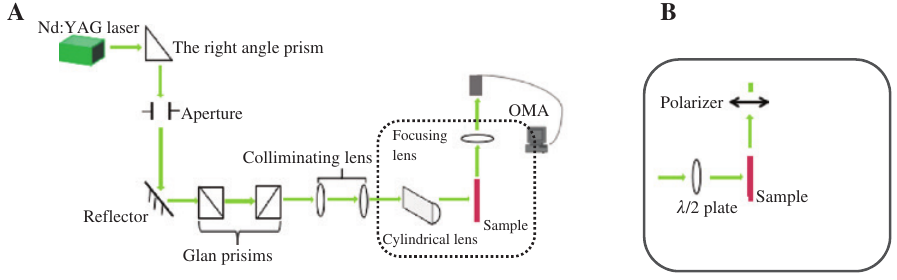
Figure 2: The sketch of the experimental setup. (A) The group of Glan prisms is used to adjust the pump energy. The two lens are used to collimate the pump beam. (B) The half wave plate is used to make sure the polarization direction of the pump is parallel to the shear direction. The polarizer is used to detect the random laser polarization